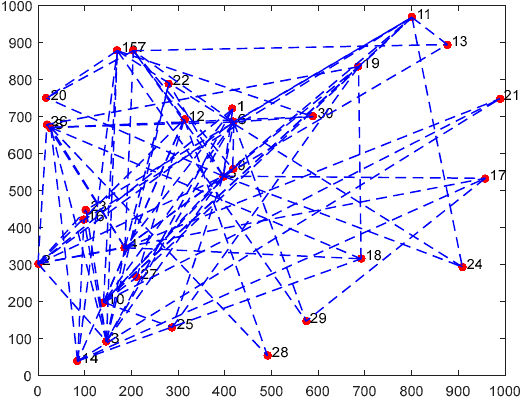
Figure 8. Cyber-side topology.